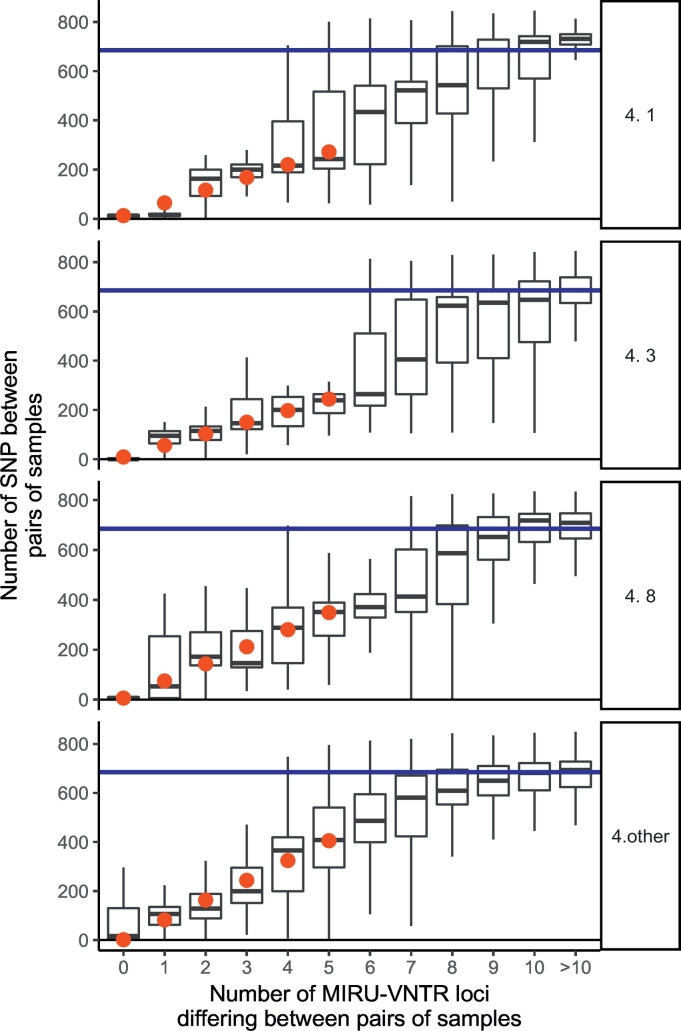
The relationship between MIRU-VNTR profile variation and SNV variation, within lineage 4.The relationship between MIRU-VNTR profile variation and SNV variation, stratified by sublineages of lineage 4, which are shown (e.g. 4.1, 4.3, etc). The x-axis shown the number of MIRU-VNTR loci differing between pairs of isolates. For example, if a sample had a MIRU-VNTR profile of 131, and another 111, one locus differs, which counts as a 1 MIRU-VNTR profile repeat number change. The y-axis shows the median number of SNV in each of a large number of pairs examined. The blue line reflects the median pairwise distance within all sampled isolates of each sublineage. Red dots are fitted median values from a multivariable quantile regression model relating SNV (dependent variable) to lineage, MIRU-VNTR profile difference between 0 and 5 loci, inclusive, and their interaction.